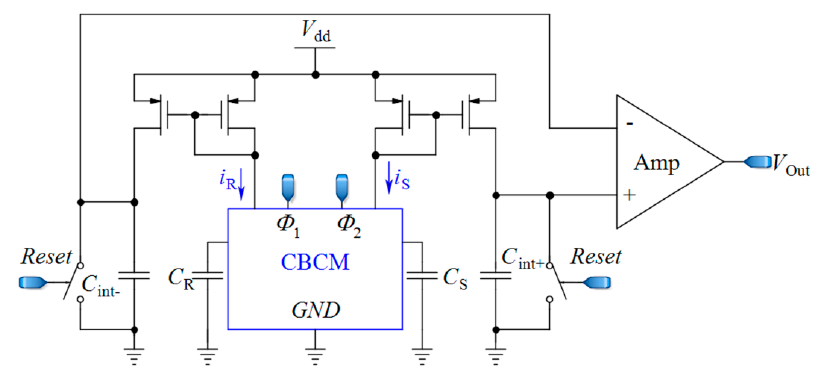
Figure 3. A core-CBCM capacitance-to-voltage converter (CVC) that integrates the currents i S and i R before subtraction (adapted from [61]).